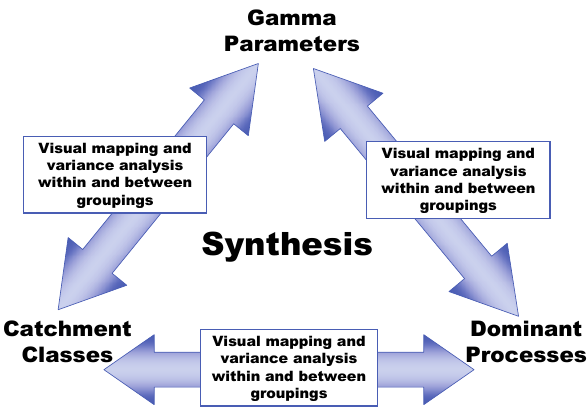
Fig. 3. Connections to be explored between the three aspects of the FDC